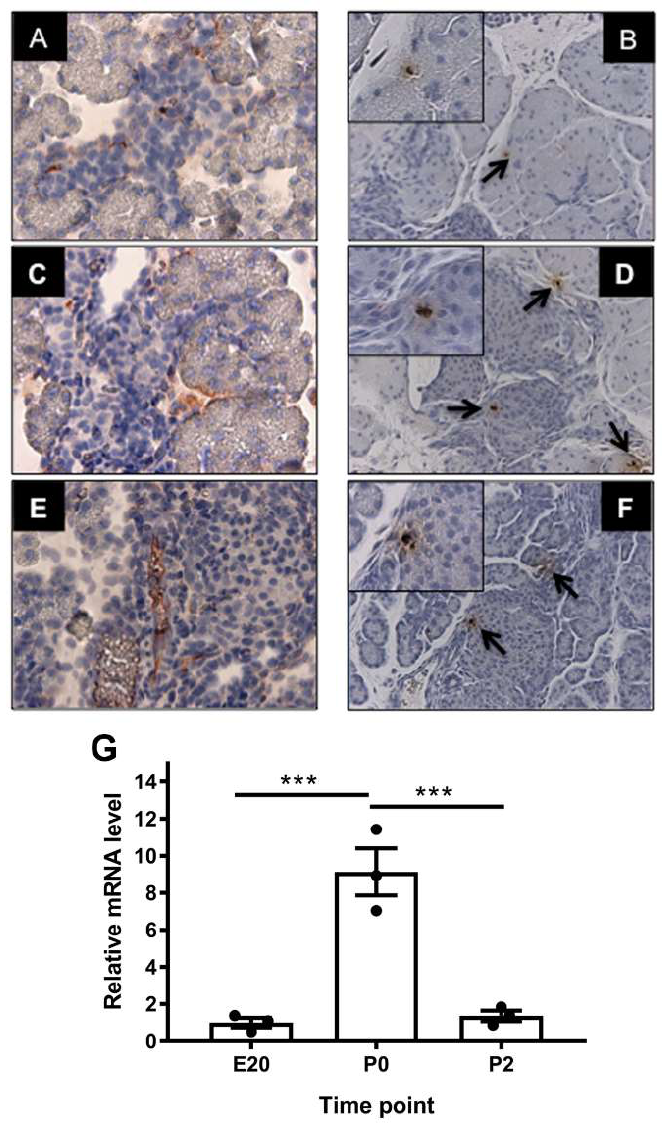
Figure 2. Expression and cellular localization of Afp in rat pancreas samples at E20, P0, and P2. ( A , C , E ) In situ hybridization of Afp mRNA using a dioxigenin-labeled LNA™ probe targeted against the same rat Afp sequence as the primers for RTqPCR (Qiagen, Exiqon, Vedbaek, Denmark) at E20 ( A ), P0 ( C ), and P2 ( E ). Afp is primarily expressed in association with islets of Langerhans in vessels and intra-islet capillaries. ( B , D , F ) Immunohistochemical detection (200 × magnification) of Afp protein in 3 µ m tissue sections from rat pancreas samples at E20 ( B ), P0 ( D ), and P2 ( F ). Afp is primarily detected in association with the endocrine compartments or ducts (arrows). Inserts at 400 × magnification. ( G ) RTqPCR of Afp mRNA in rat pancreas samples at E20, P0, and P2. The mRNA values are normalized to Rpl13alpha . Afp mRNA expression is significantly increased at P0 compared to E20 and P2 (two-tailed t -test, p < 0.01). Note: *** p <